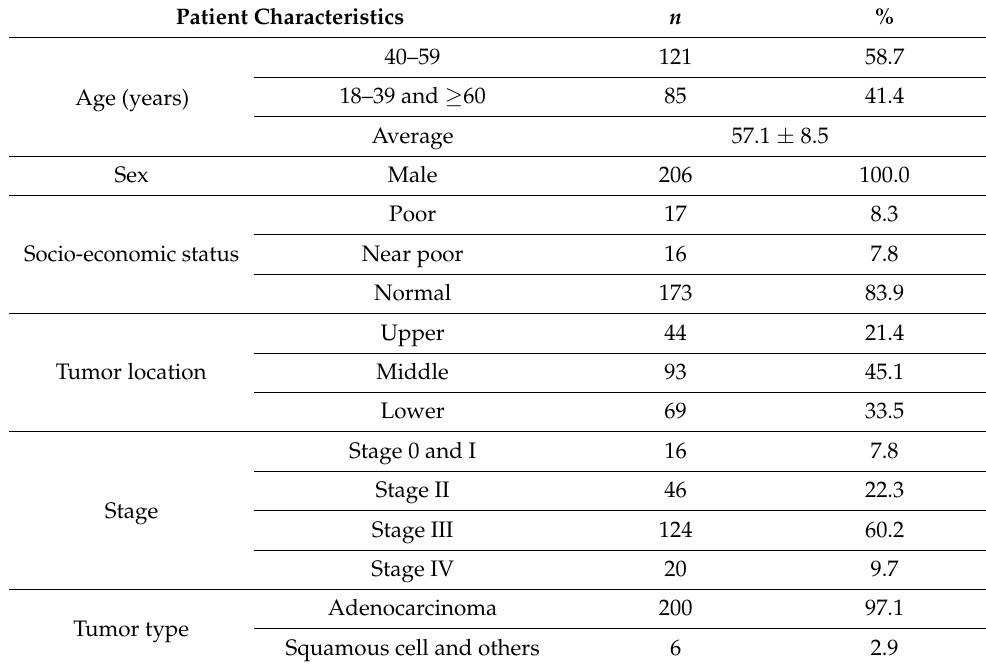
Table 1. Patient characteristics.